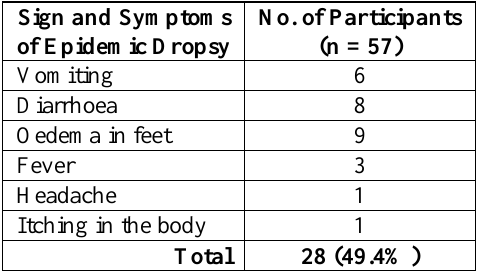
Table 1. Awareness of sign and symptom